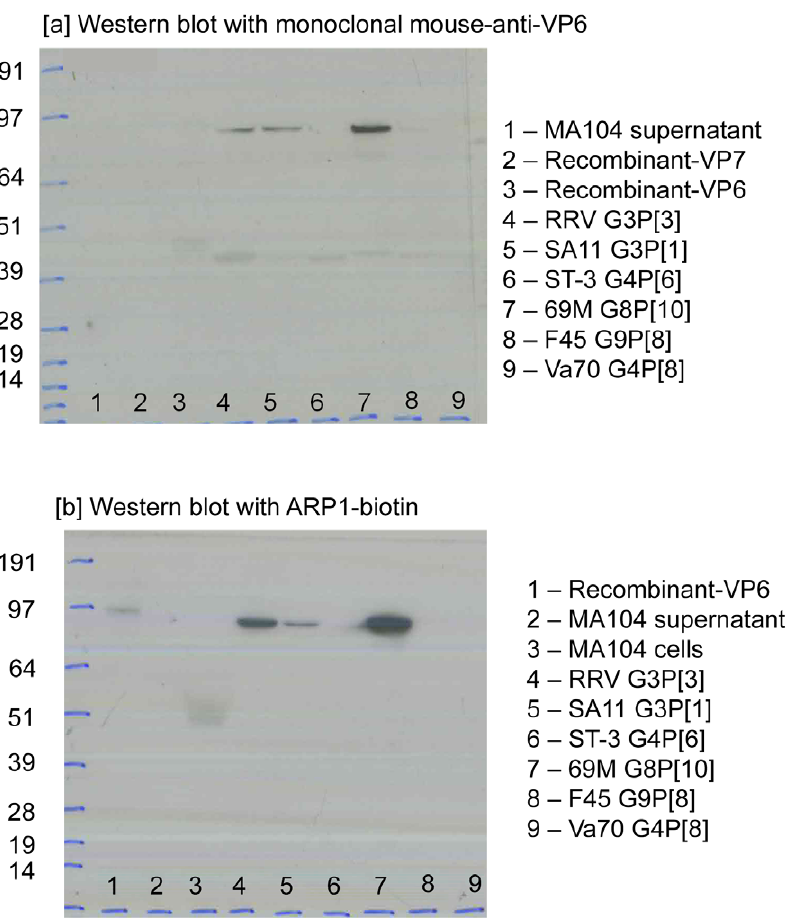
Figure 2. Western blots. Western blots were performed with either [a] monoclonal mouse anti-VP6 or [b] ARP1-biotin. Concentrated cell adapted rotaviruses were run on an SDS-PAGE gel, transferred to a nitrocellulose membrane, and blotted with appropriate antibodies.